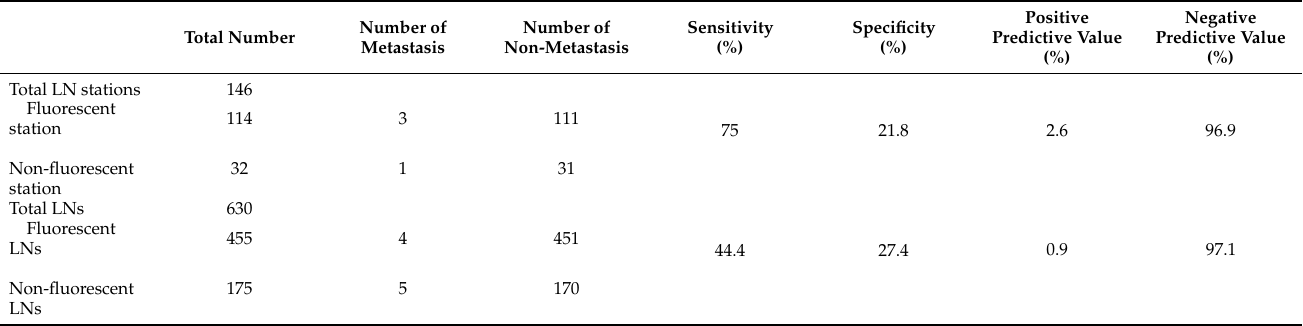
Table 4. Diagnostic value of fluorescent lymphography based on stations and lymph nodes.